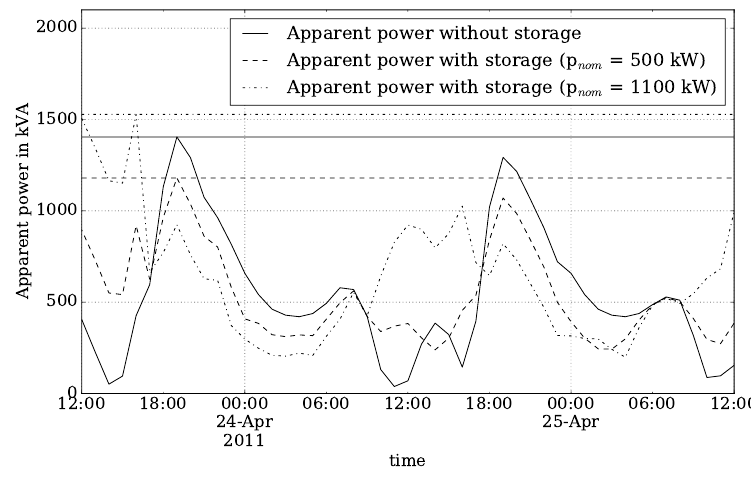
Figure 9. Illustration of the approach of finding the storage size that minimizes the maximum load in a